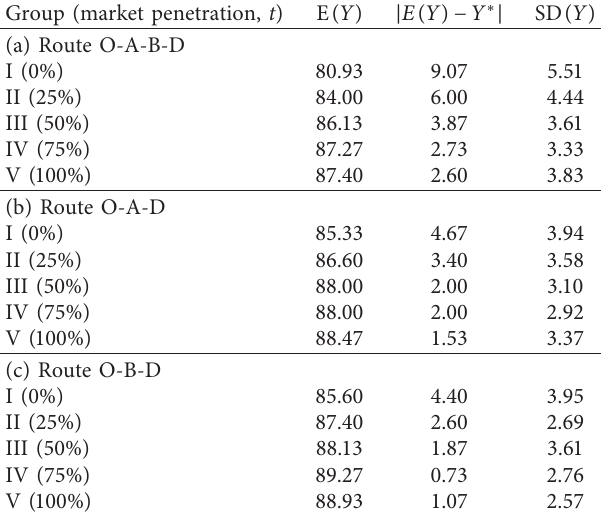
Figure 5: Fluctuation of actual travel time in five groups of experiments. (a) Group I, (b) Group II, (c) Group III, (d) Group IV, and (e) Group Table 7: Mean and standard deviation of travel time on each route in each group of experiments.